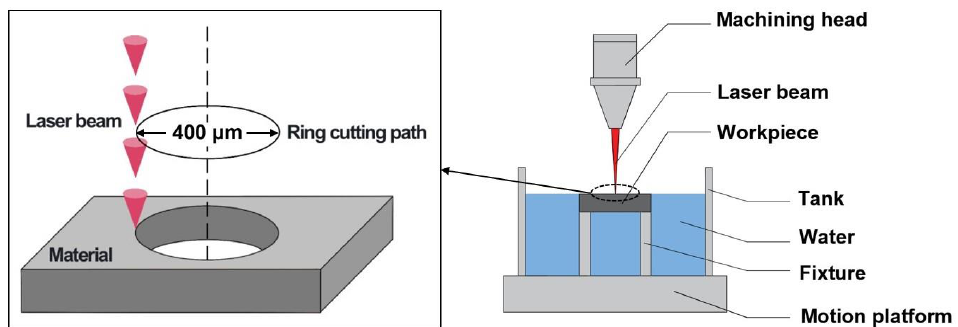
Figure 1. Schematic diagram of millisecond laser trepanning with water-based assistance. Table 1. Laser parameters used in air and water-based assistance.